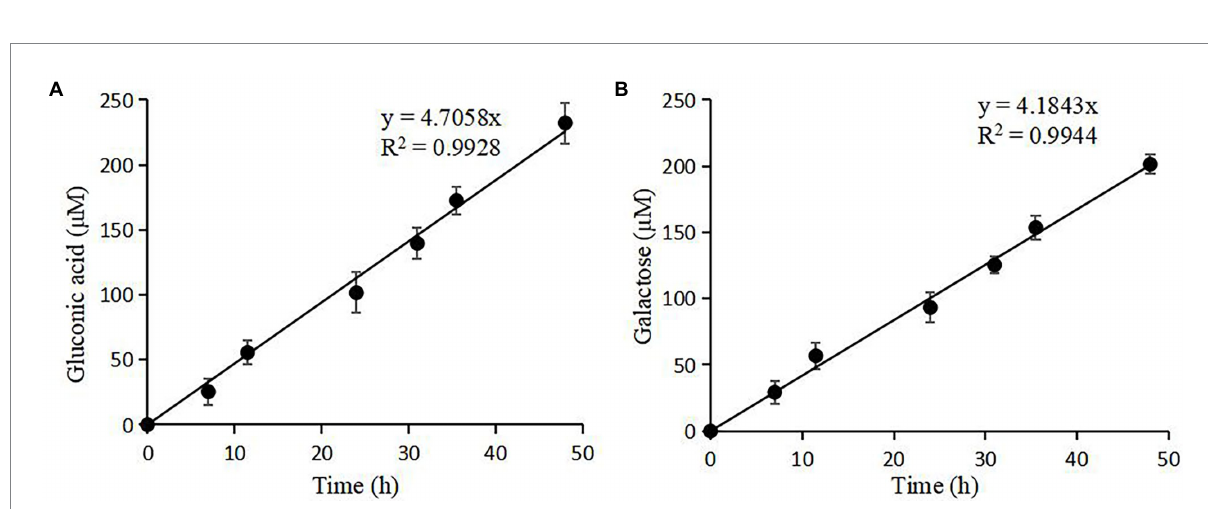
FIGURE 3 Quantification of the reaction products of nTaAA9A by HPLC-RID analysis. (A) TFA hydrolyzed the reaction products of nTaAA9A, and then gluconic acid was quantified with HPLC-RID analysis. (B) The reaction products of nTaAA9A were reduced by NaBH 4 followed by hydrolysis with TFA. Then, galactose was quantified with HPLC-RID analysis. All experiments were performed in three replicates, and error bars indicate the standard deviation.